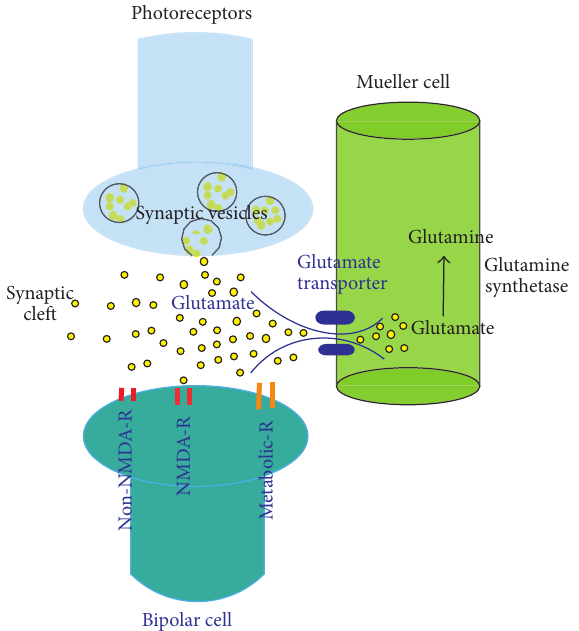
Figure 1: Glutamatergic synaptic transduction and uptake and metabolism of glutamate in the M¨uller cell. The photoreceptor cell synthesizes glutamate, which is continuously released during darkness. Glutamate released from the synaptic terminal reaches to the postsynaptic receptors of bipolar cell dendrites, then is promptly taken up from the synaptic cleft. The glutamate transporters are the predominant mechanism for uptake of glutamate in the M¨uller cell, andmaintaintheproperconcentrationofthispotentiallyexcitotoxic amino acid. Glutamate transported into the M¨uller cell is degraded to glutamine by glutamine